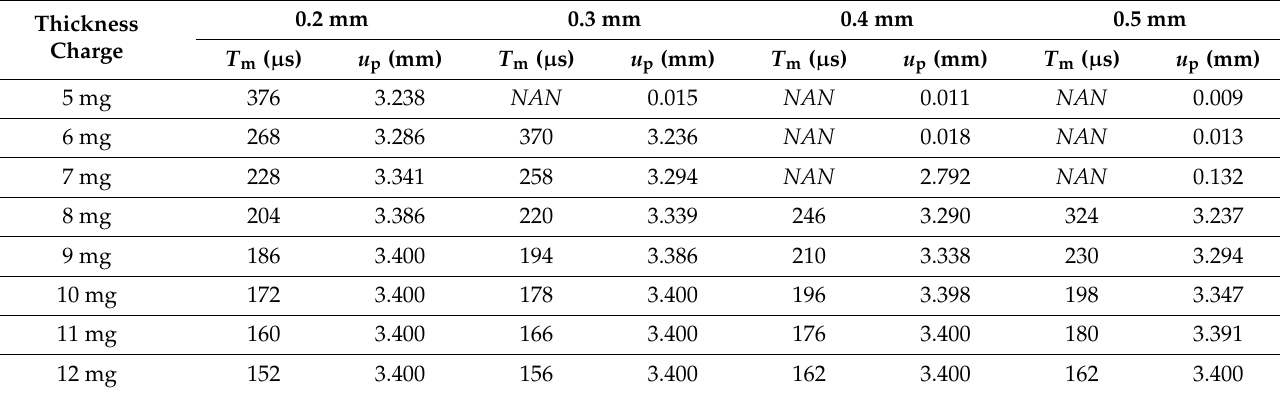
Figure 12. Dynamic characteristics: ( a ) maximum displacement of piston, ( b ) movement time. Table 4. Specific data of dynamic characteristics.